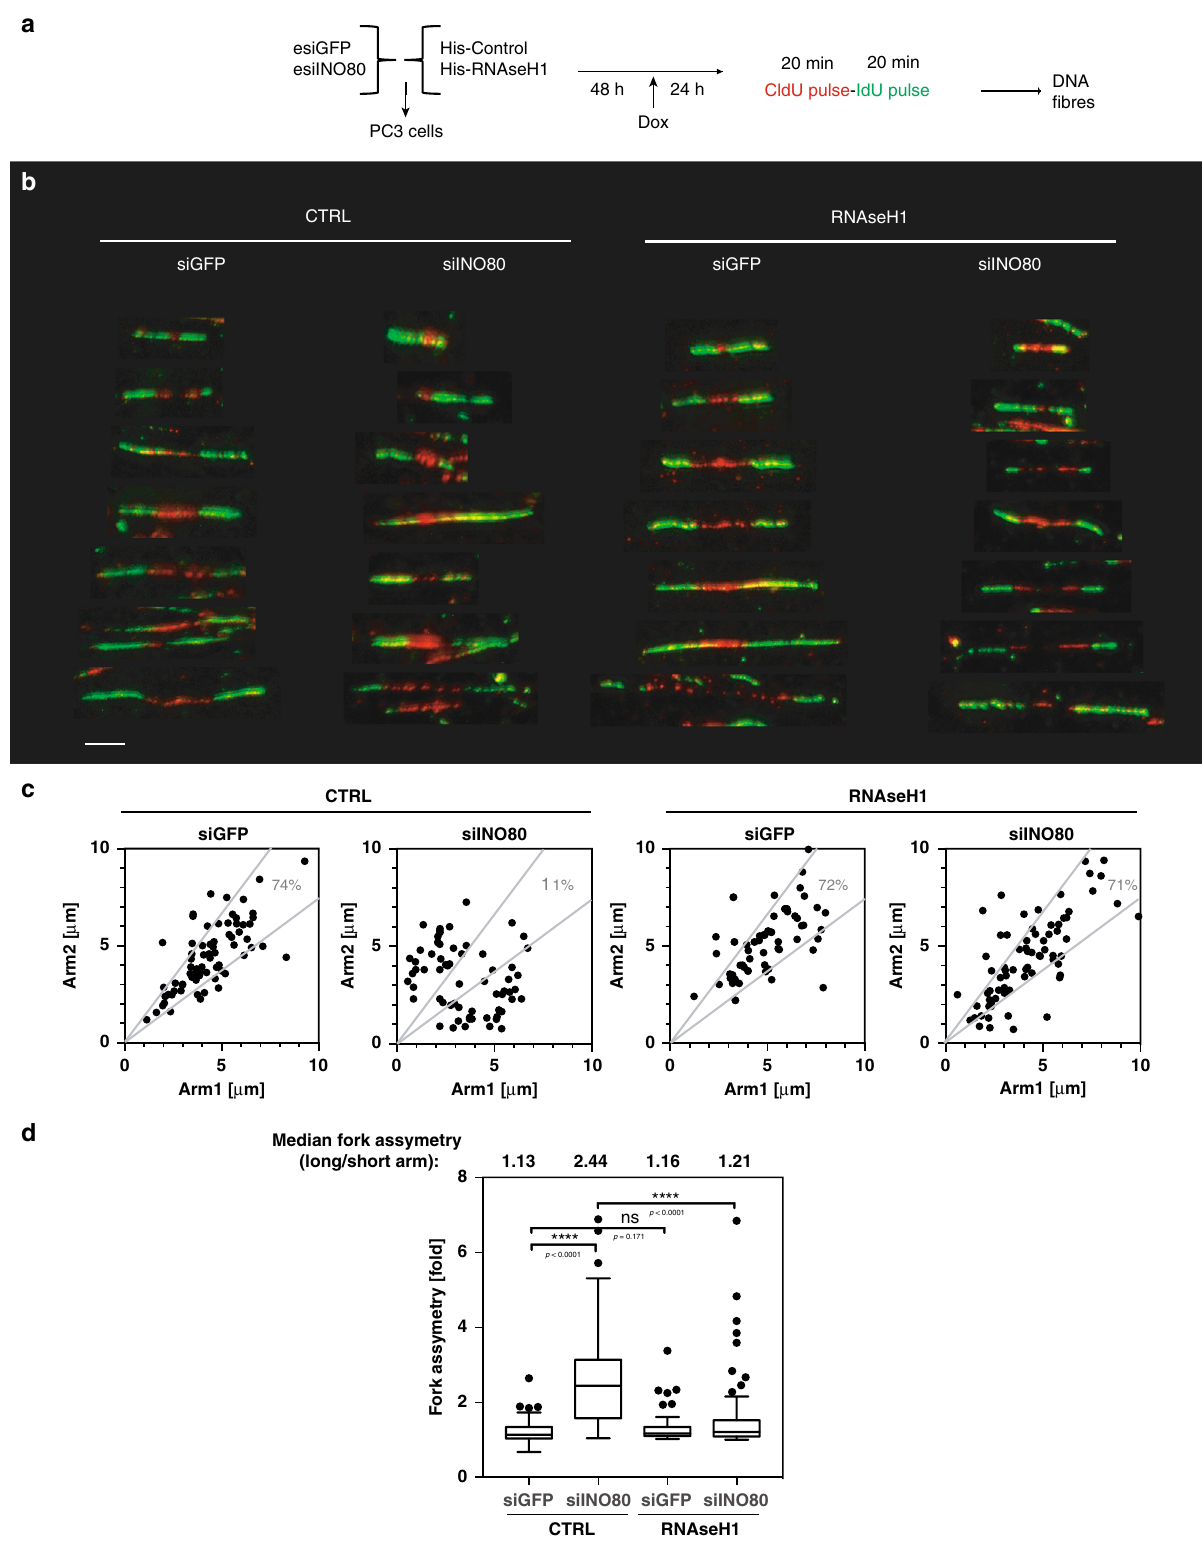
Contrary, the global colocalization between the STED INO80 and STED S9.6 R-loop signals was not random (Supplementary Table 1). This suggests true R-loop:INO80 colocalization events. Only a subset of INO80 foci co-localized with R-loops. To quantify the percentage of R-loop objects with overlapping volume with INO80 objects, we created 3D volume objects